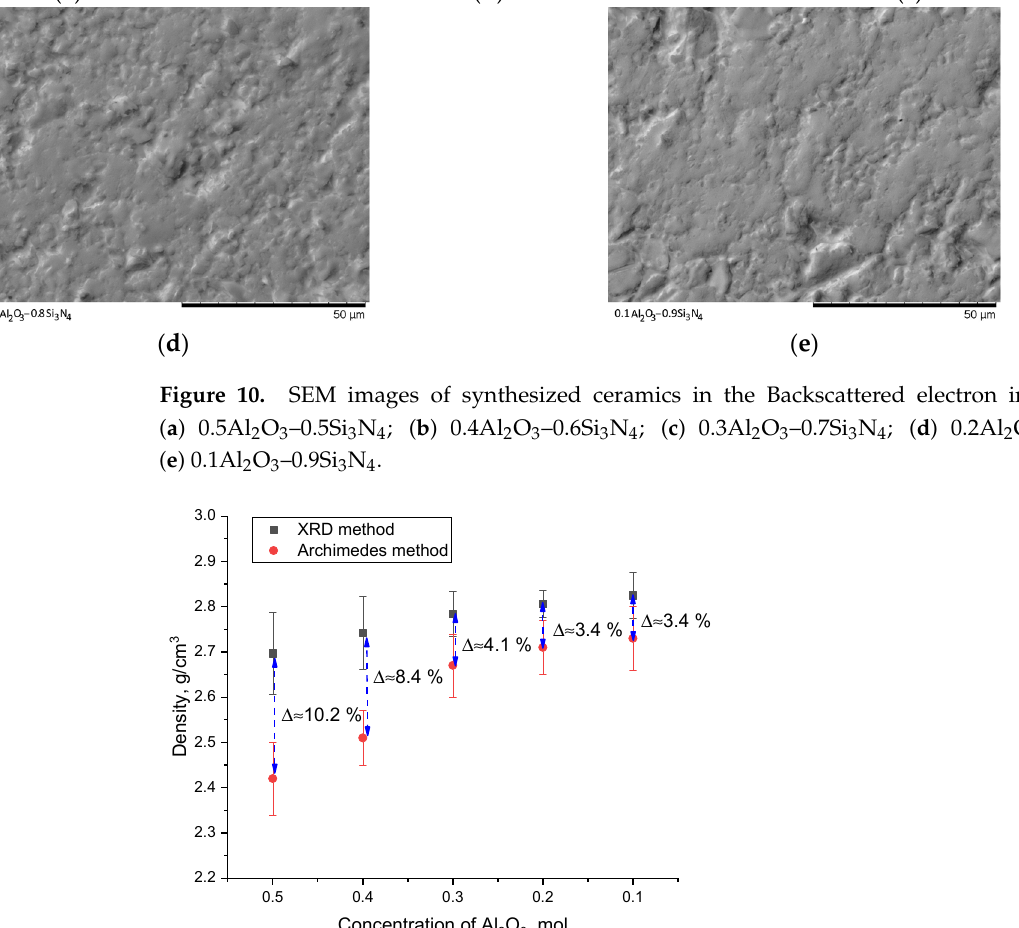
Figure 11. These changes in the density of ceramics, depending on the variation of the components.